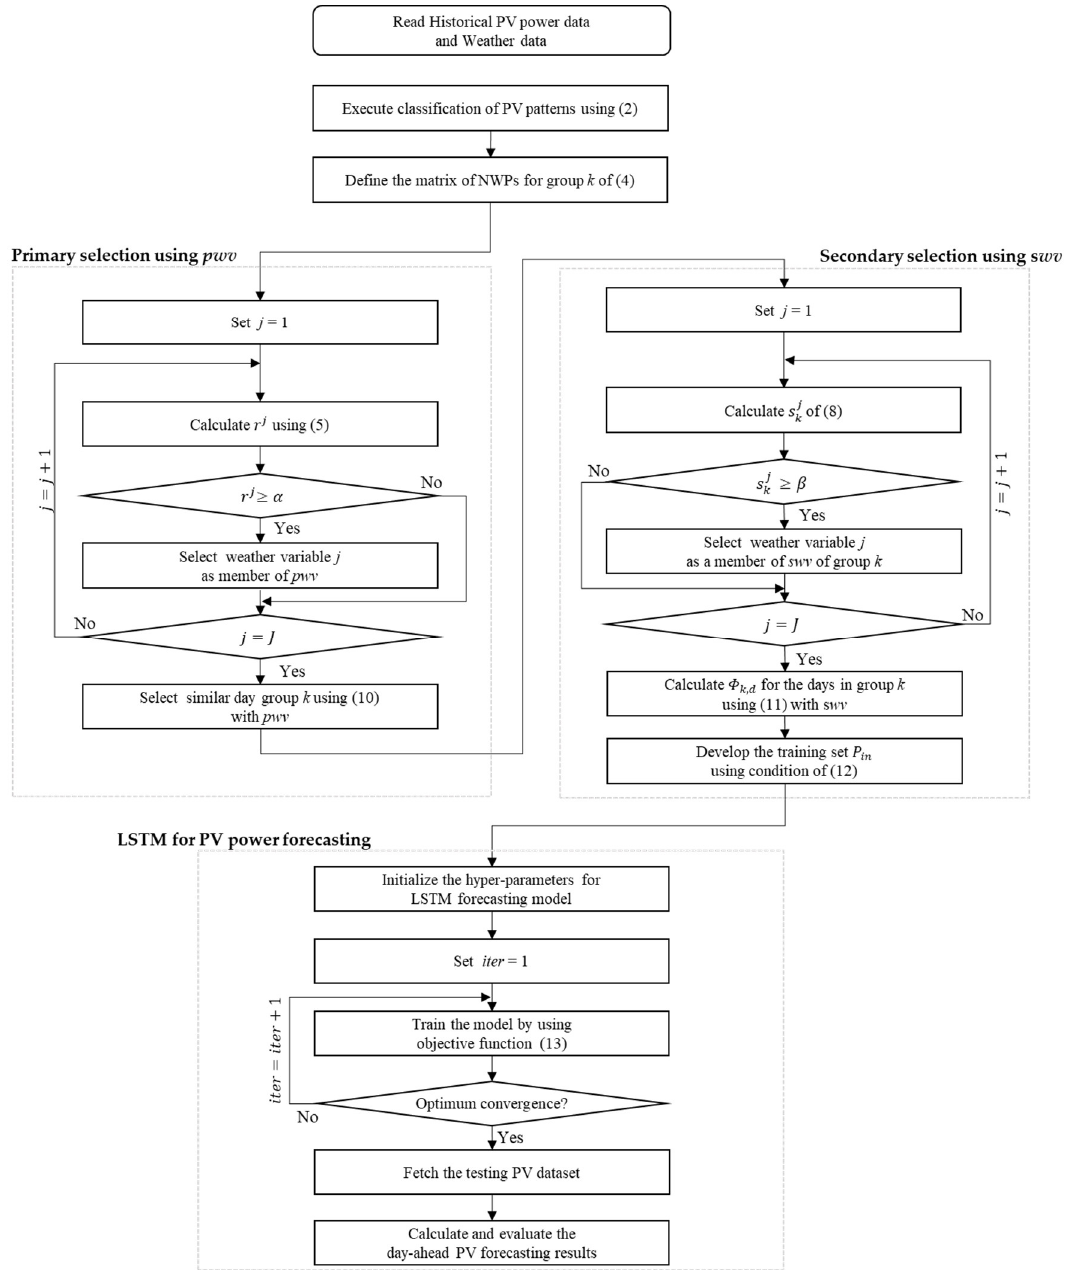
Figure 6. The overall procedure of the proposed PV power forecasting method.